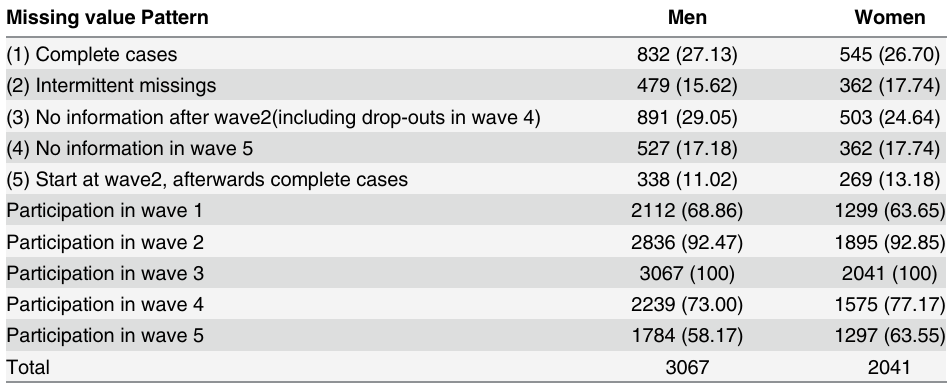
Table 1. Missing value patterns and participation in waves in the sample – Frequency (%). Missing value